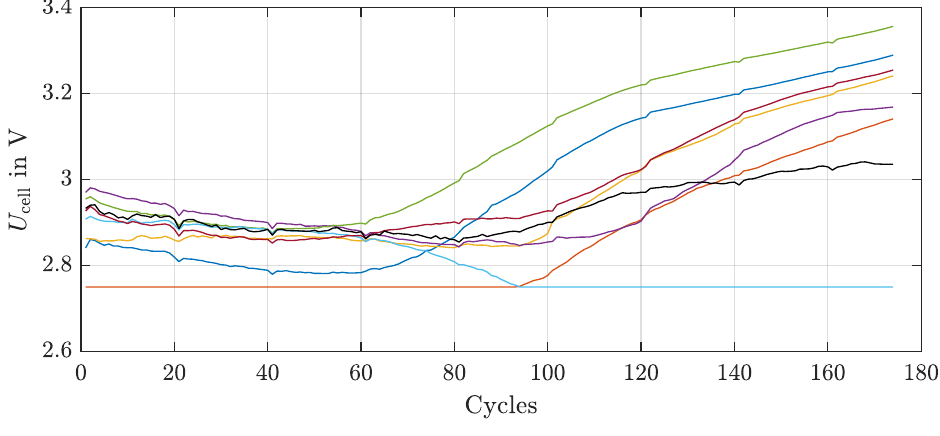
Figure 3. Voltages at the end of the discharging phase.